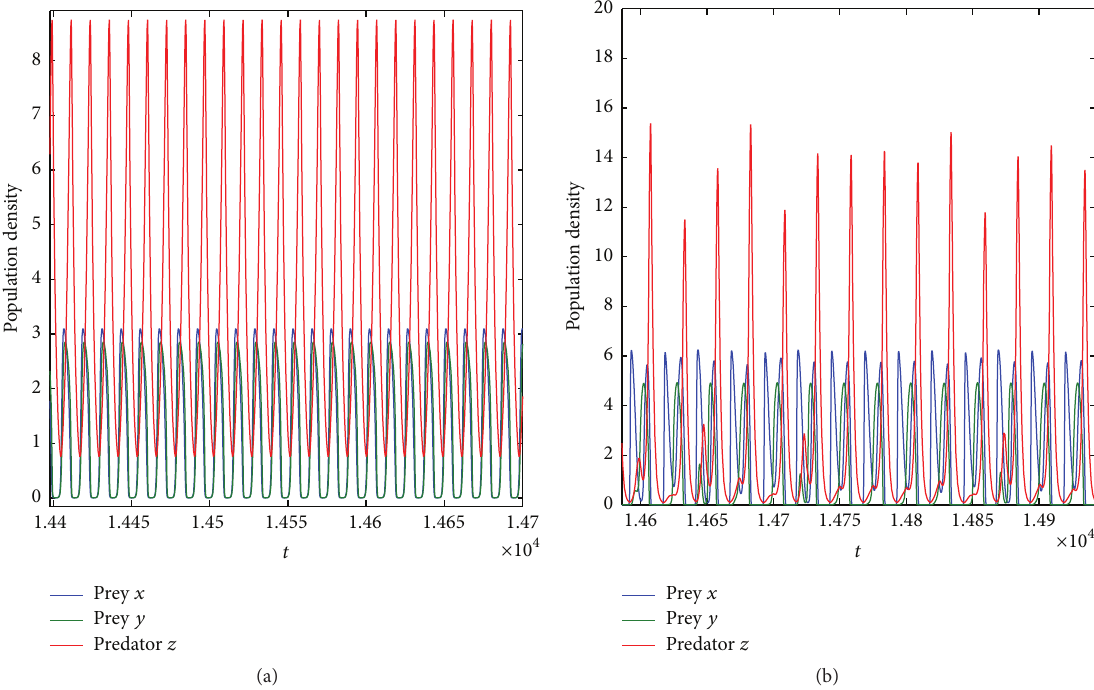
Figure 2: Solution trajectories of system (1) with mixed Holling type II–IV responses ( 𝑝 = 1 , 𝑞 = 1 , 𝑠 = 1 , and 𝑟 = 2 ) showing (a) periodic behavior in absence of seasonal perturbation and (b) quasiperiodic behavior in presence of seasonal perturbation with data set